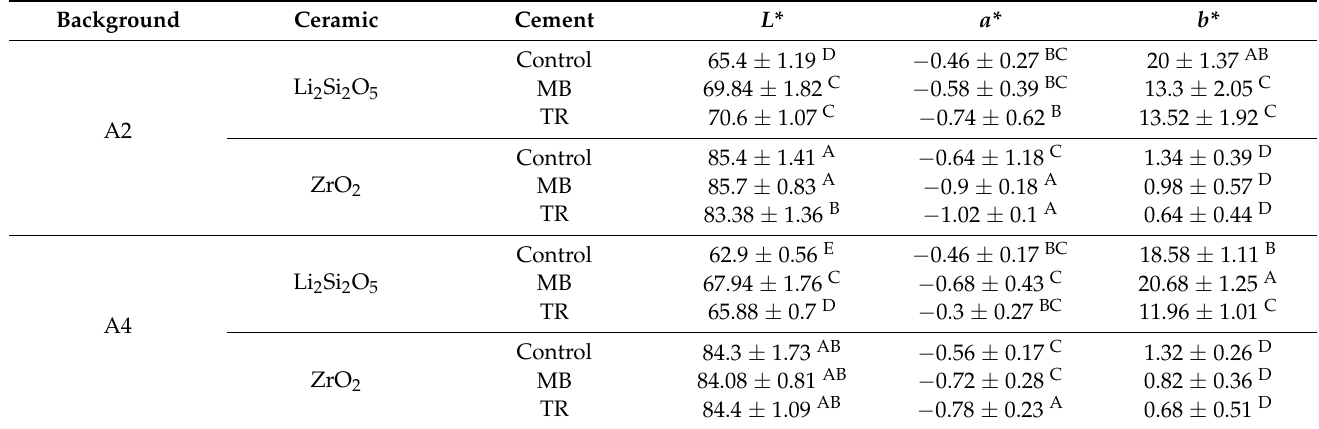
Table 4. Means and standard deviation for L*a*b* values. Similar superscript letters indicate no statistically significant difference ( p > 0.05). Different superscript capital letters indicate significant difference within column ( p < 0.05).